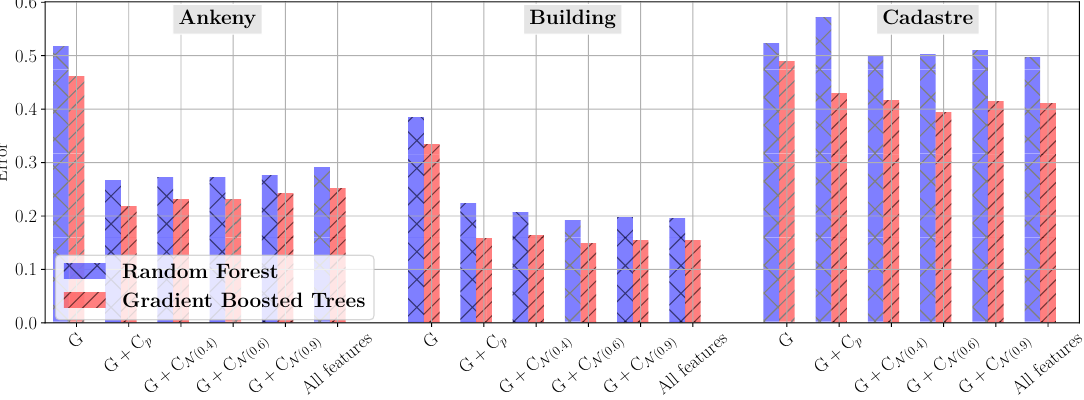
Figure 2. Inter-dataset results: classification error (number of misclassified points divided by overall number of points, the lower the better) when training on two datasets and testing on the remaining one. Similar to Fig. 1, the best results are obtained with both geometric and color features C N (0 . 6) . The results on Ankeny and Cadastre show higher classification errors than those obtained when training and testing on the same dataset in Fig. 1. This is due to the lack of training data for certain objects or terrain type. For a detailed discussion see section 4.4.